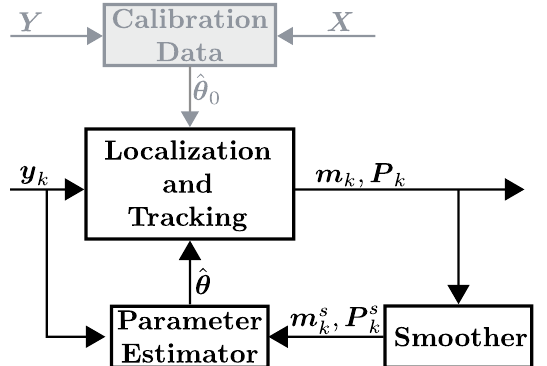
Figure 1. The components of a typical and proposed DFLT system. The gray shaded block and localization-and-tracking block is common to conventional systems, whereas the proposed system is composed of the non-shaded blocks only. The notation is introduced in Sections 3 and